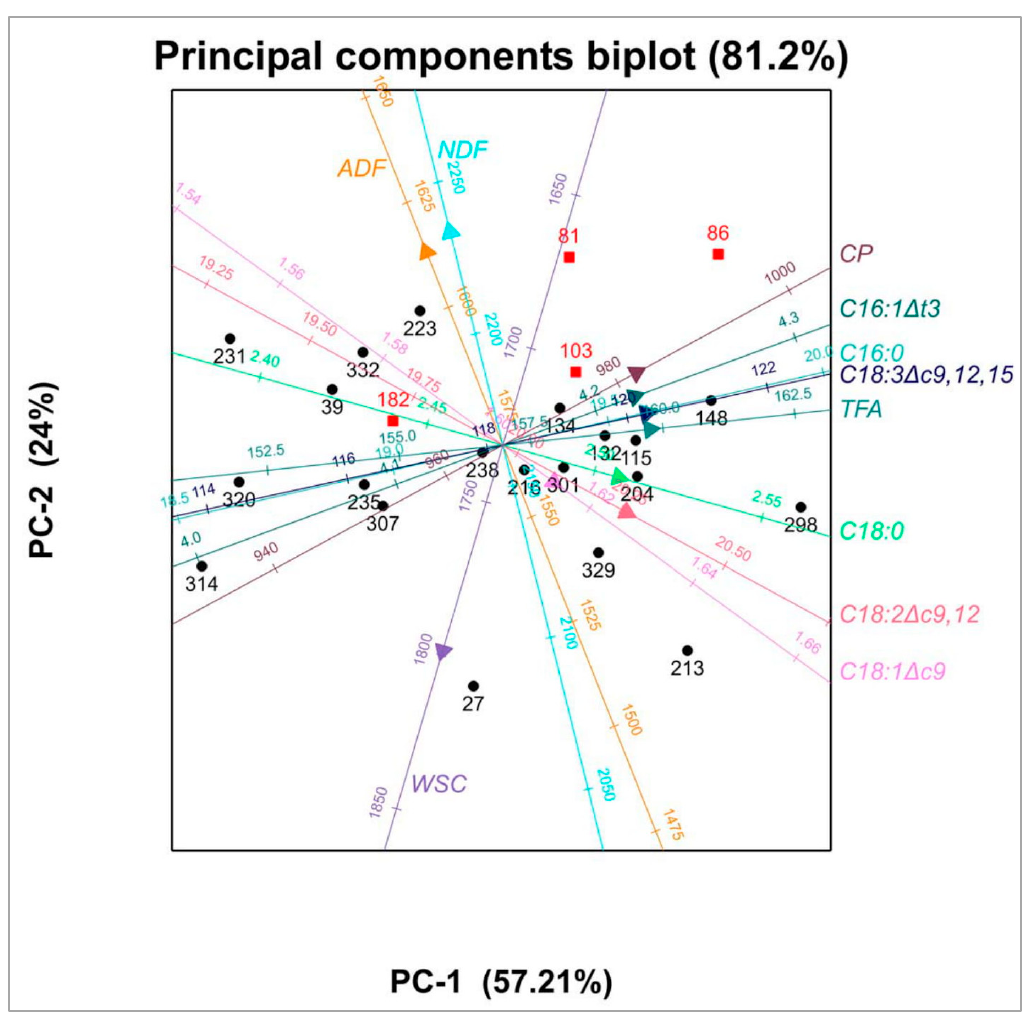
Figure 2. Bi-plot of the first and second principal components. Genotypes from the breeding population are indicated by a black circle [ • ] and genotypes from the mapping population are indicated by a red square [ (cid:4) ]. Vector labels: CP, crude protein; WSC, water-soluble carbohydrate; ADF, acid-detergent fibre; NDF, neutral detergent fibre; C16:0, palmitic acid; C16:1 ∆ t3 , trans -3-hexadecenoic acid; C18:0, stearic acid; C18:1 ∆ c9 , oleic acid; C18:2 ∆ c9,12 , linoleic acid; C18:3 ∆ c9,12,15 , α -linolenic acid; TFA, total fatty acids.